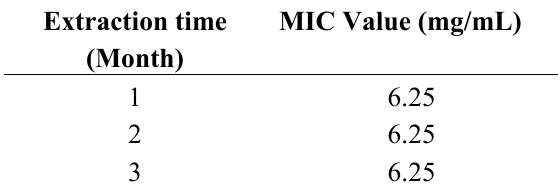
Table 1. Minimum inhibitions concentration value of Cassia